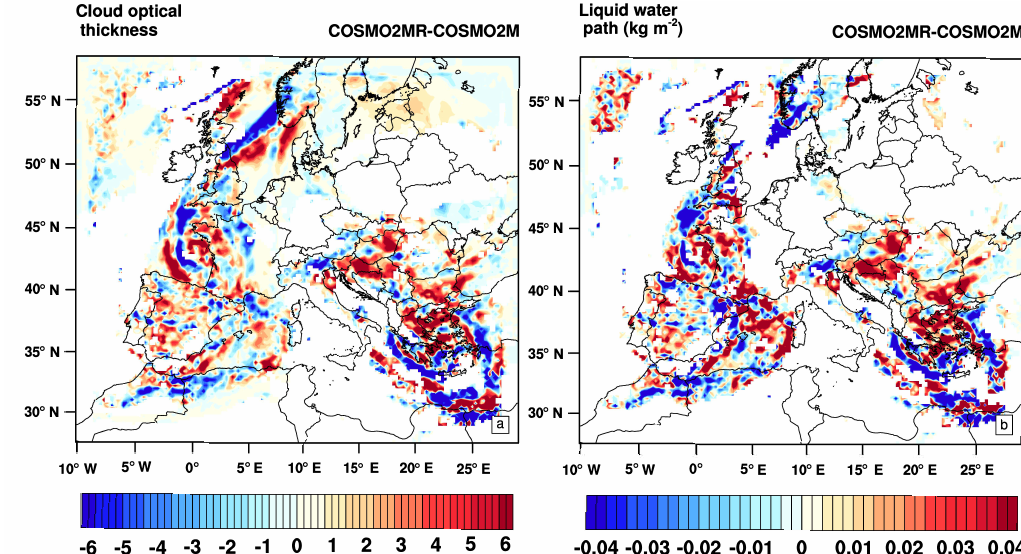
Figure 8. Daily averaged cloud optical depth and liquid water path differences between COSMO2MR and COSMO2M on 17 February 2007.